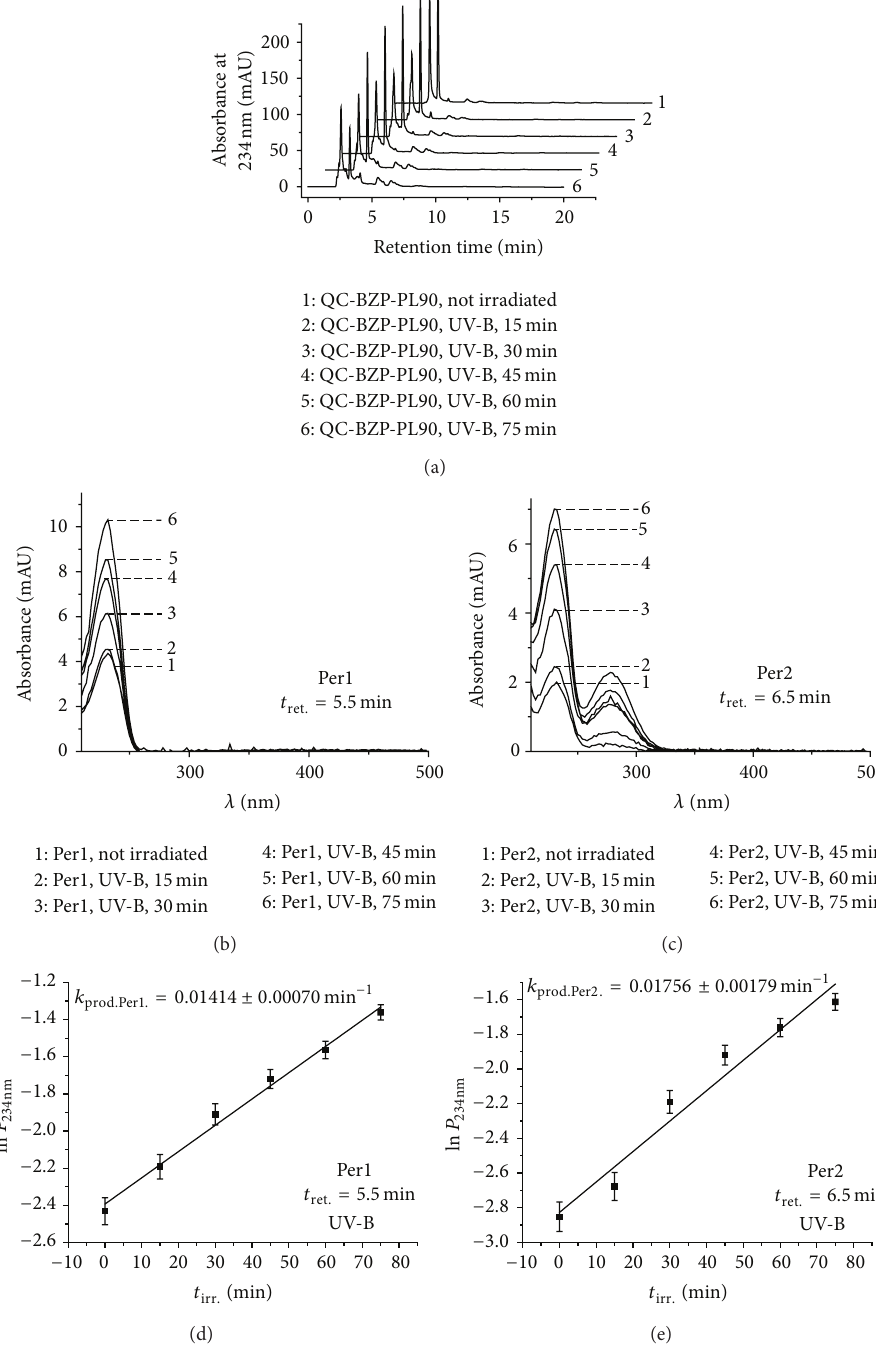
Figure 4: Formation of lipid peroxides in the UV-B-irradiated sample, that is, quercetin/BZP/phospholipids mixture in methanol. (a) The recorded samples chromatograms recorded at 234 nm (peroxides retention times, 𝑡 peroxides absorption spectra taken from the upper (a) chromatogram (Per1 𝑡 ) . ((d) and (e)) Kinetics of rise of the two peroxides peaks (Per1 𝑡 UV-B irradiation periods (𝑡 irr . areas as a result of the increased UV-B irradiation periods, ln 𝑃 234 are shown in the